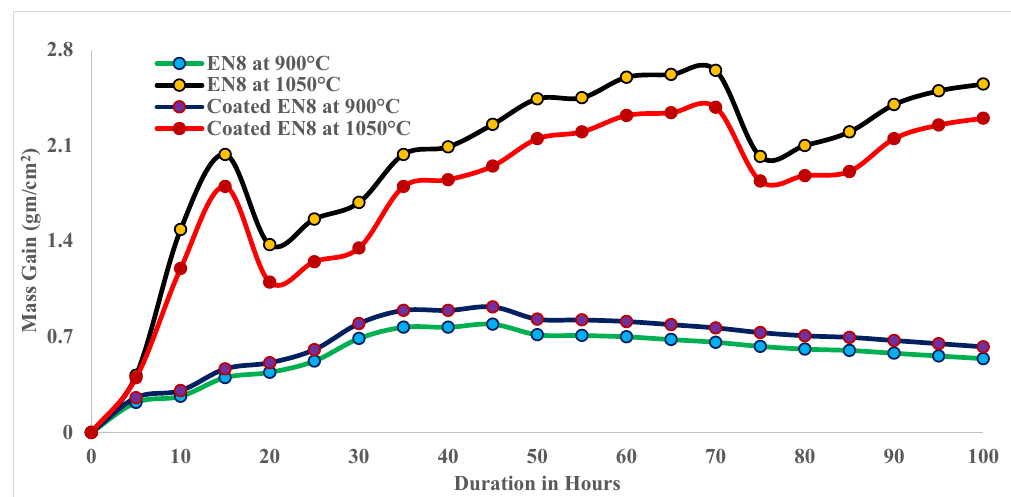
Figure 7. EN8’s mass gain vs. oxidation duration before and after deposition.